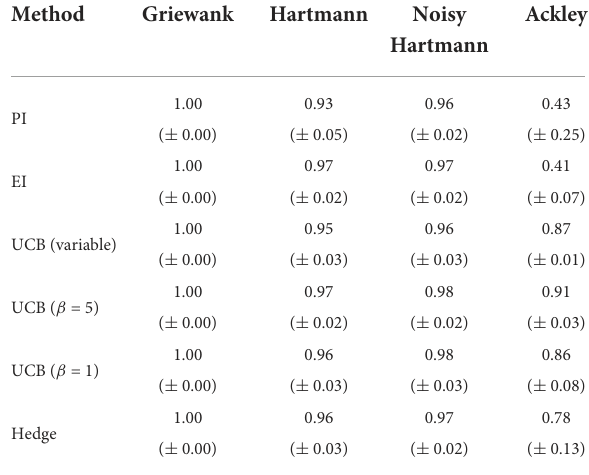
TABLE 4 Averaged area under the curve with standard error for analytical single-point acquisition functions with 10 initial training points per input